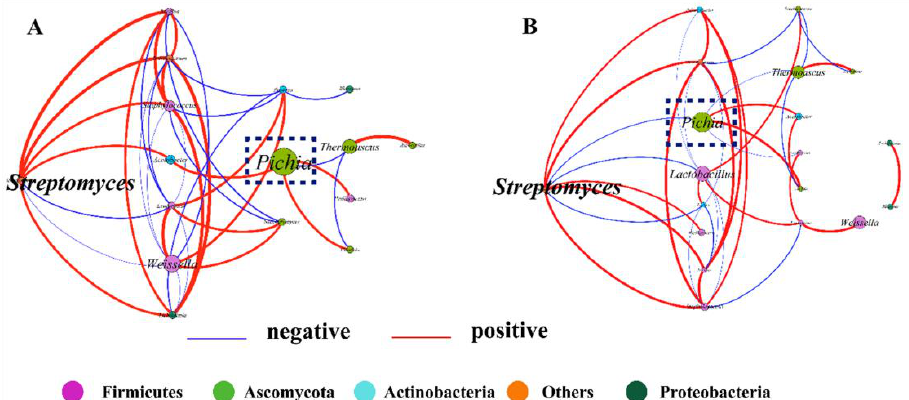
Figure 6. Relationships among microbial communities in the control group ( A ) and test group ( B ). A connection represents a significant ( p < 0.05) and strong (Spearman’s | ρ | > 0.6) correlation. The size of each node is in proportion to the relative abundance of each microorganism, and the nodes are colored by phylum (Firmicutes, purple; Ascomycota, green; Actinobacteria, blue; others, orange; Proteobacteria, dark green.). The Spearman’s correlation coefficient ( ρ ) is in proportion to the thickness of each connection (edge) between two nodes. The color of the edges represents the positive (red) or negative (blue) relationship. The Pichia circled in the box is the main microorganism that inhibits the growth of Streptomyces